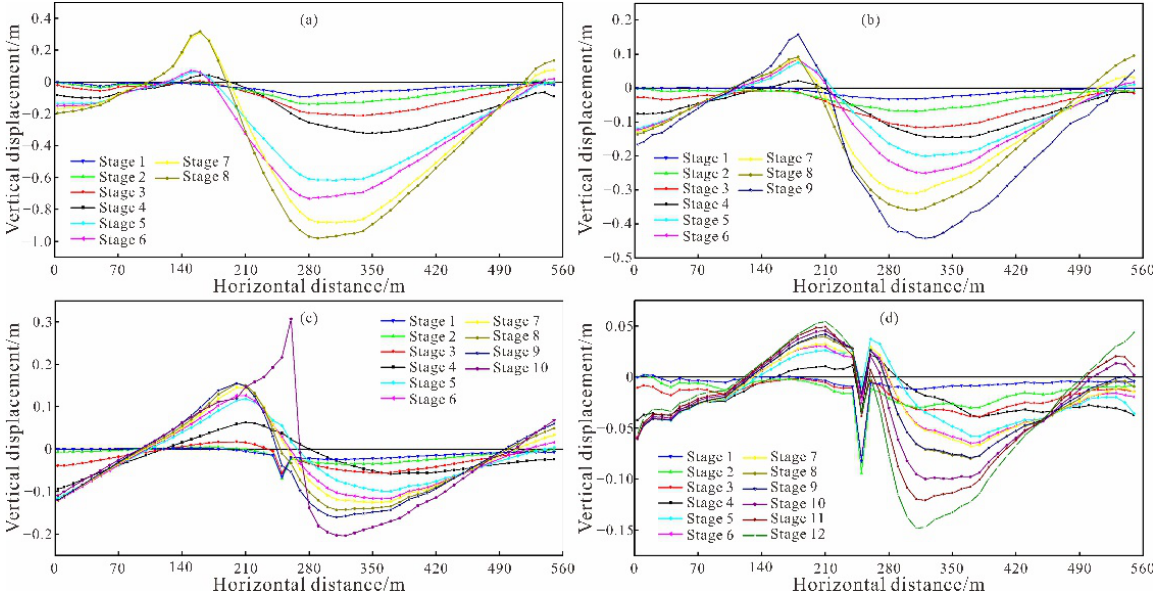
Figure 7. Physical model test process. ( a ) Dip angle of 45°; ( b ) dip angle of 55°; ( c ) dip angle of 65°; ( d ) dip angle of 75°.